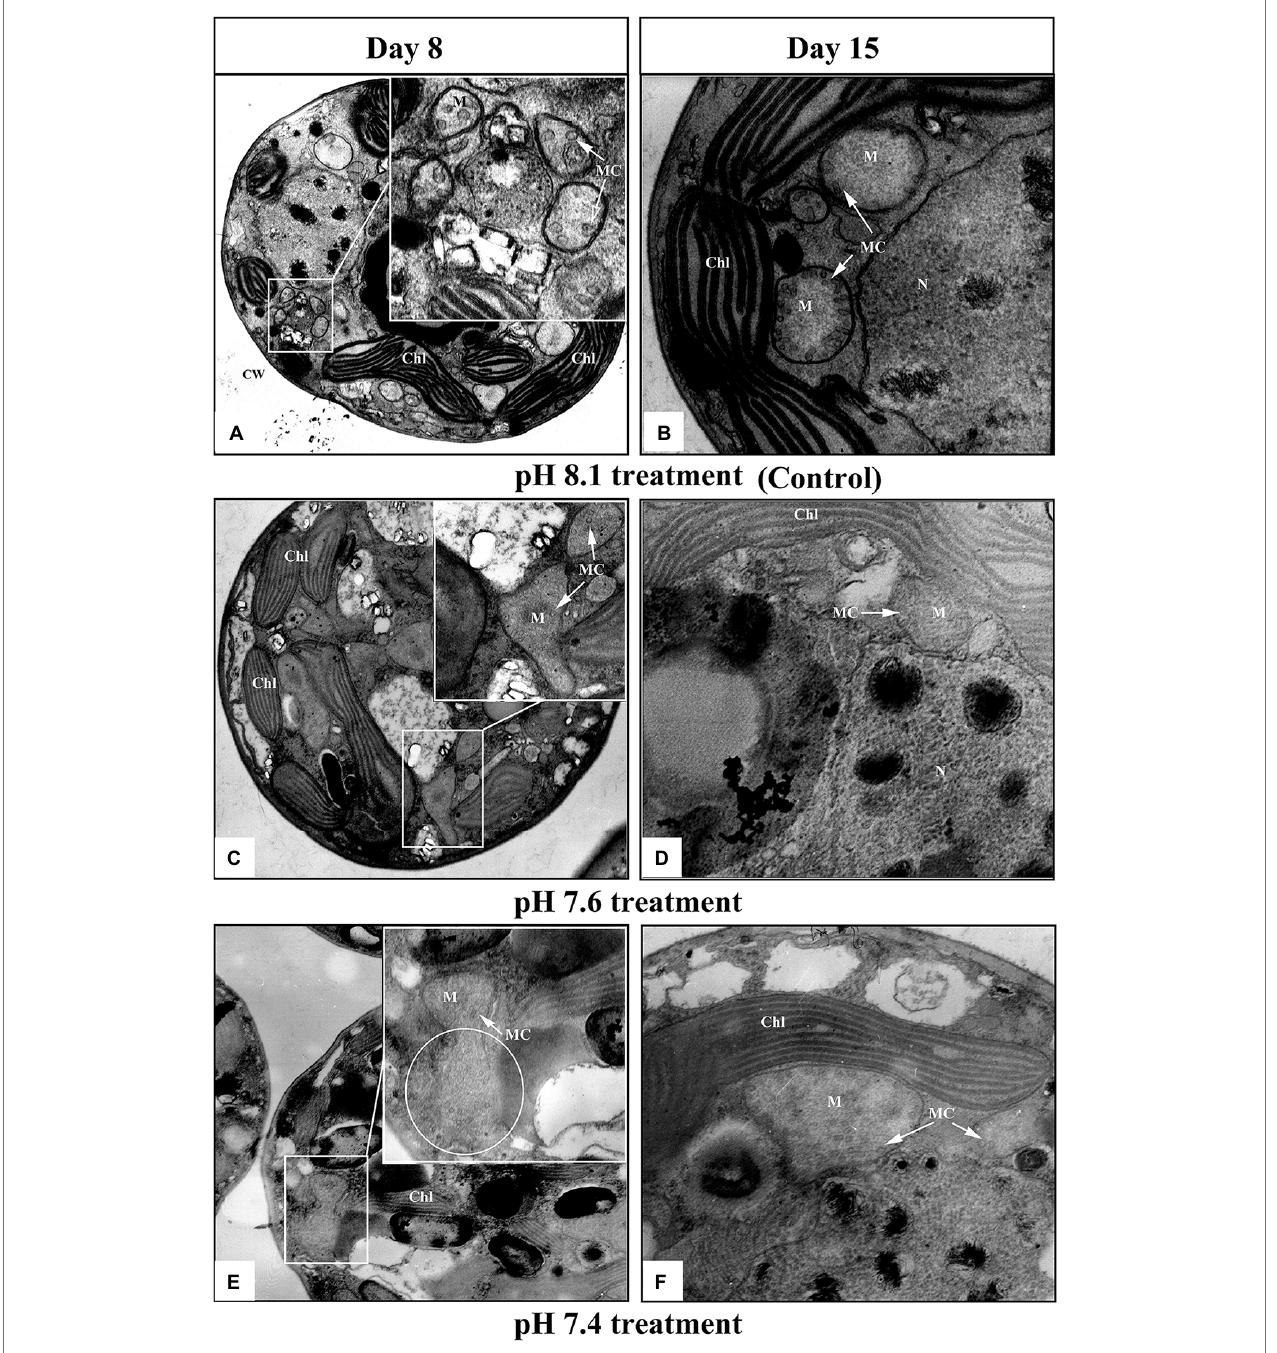
FIGURE 2 | Ultrastructural changes in K. mikimotoi cells treated with different pH levels. (A,B) Control; (C,D) pH 7.6 treatment; (E,F) pH 7.4 treatment. CW, Chl, M, MC, and N in each figure denote the cell wall, chloroplast, mitochondria, mitochondrial cristae and nucleus, respectively. The scale of 2 μ m is indicated at the bottom of each